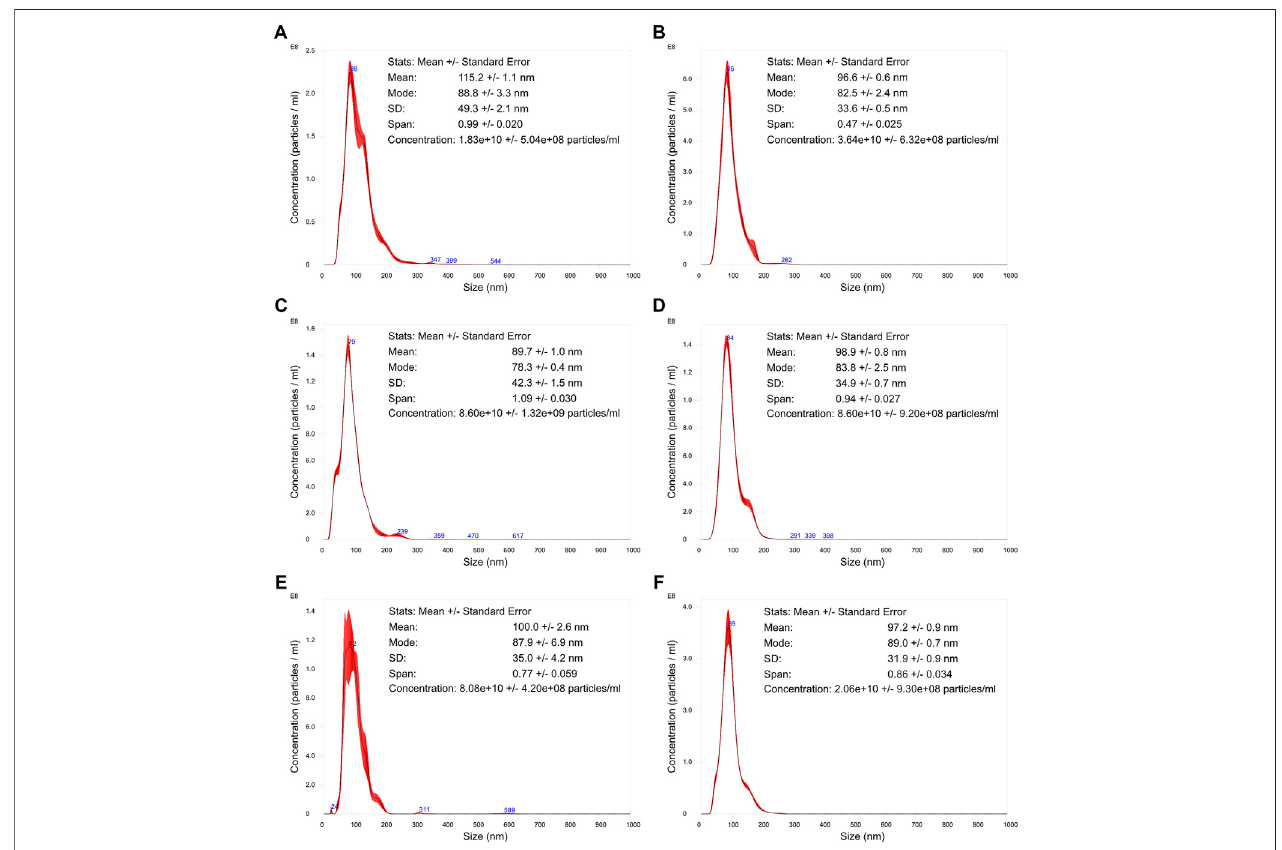
FIGURE 5 | Nanoparticle tracking analysis of in fl uenza VLPs. Particle size distribution analysis of puri fi ed samples. The represented distributions are an averaged result of fi vemeasurements. Theerrorbars (inred)indicate +/ – 1standarderrorofthemean. (A) H1MonoVLP, (B) H1Penta VLP, (C) H3Mono VLP, (D) H3PentaVLP, (E) B Mono VLP, (F) B Penta